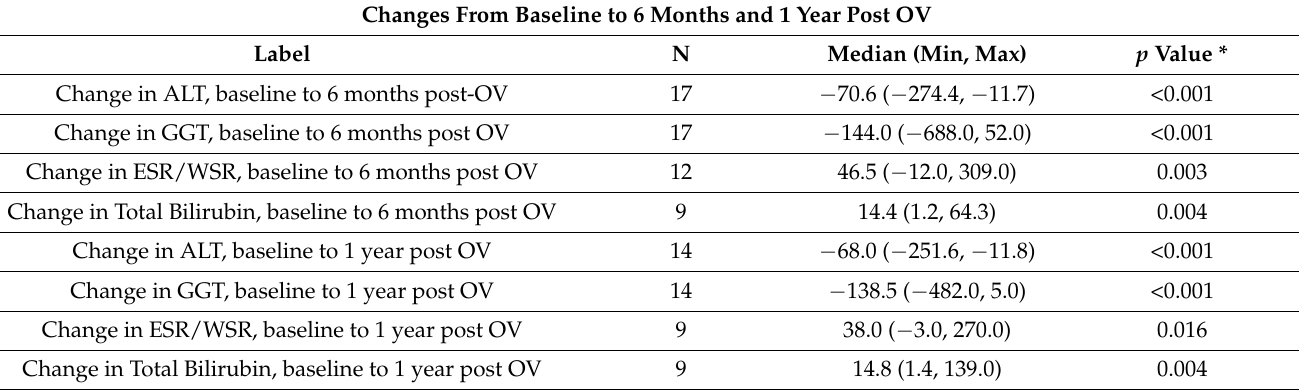
Table 4. Change in laboratory values for all included patients from baseline to 6 and 12